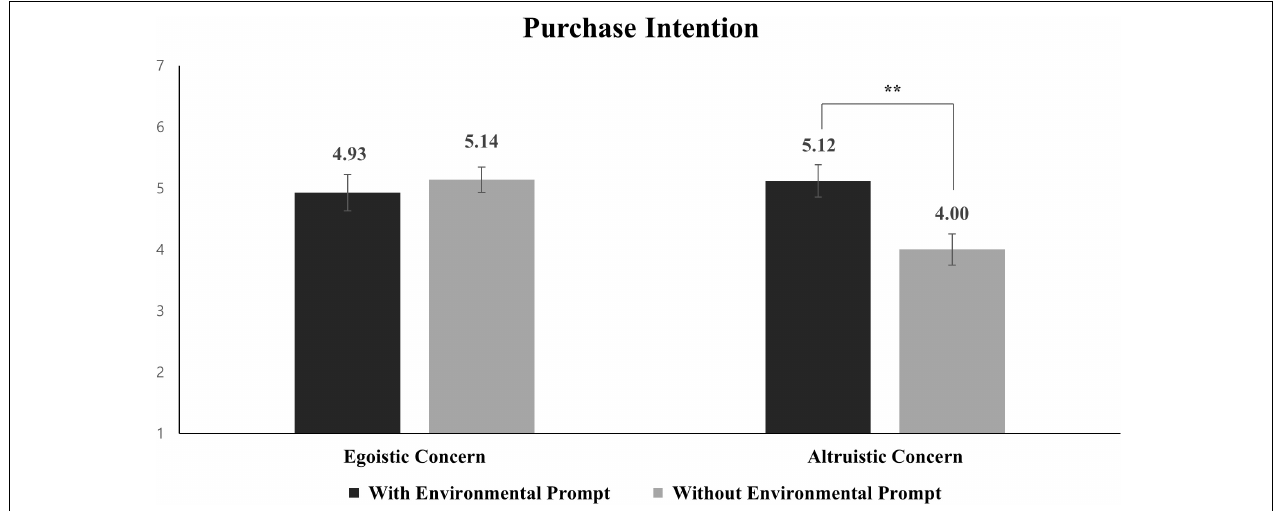
FIGURE 3 | Effects of type of concerns and with/without environmental prompt product on purchase intention (study 2). Error bars show the 95% CIs around the means. ** p <